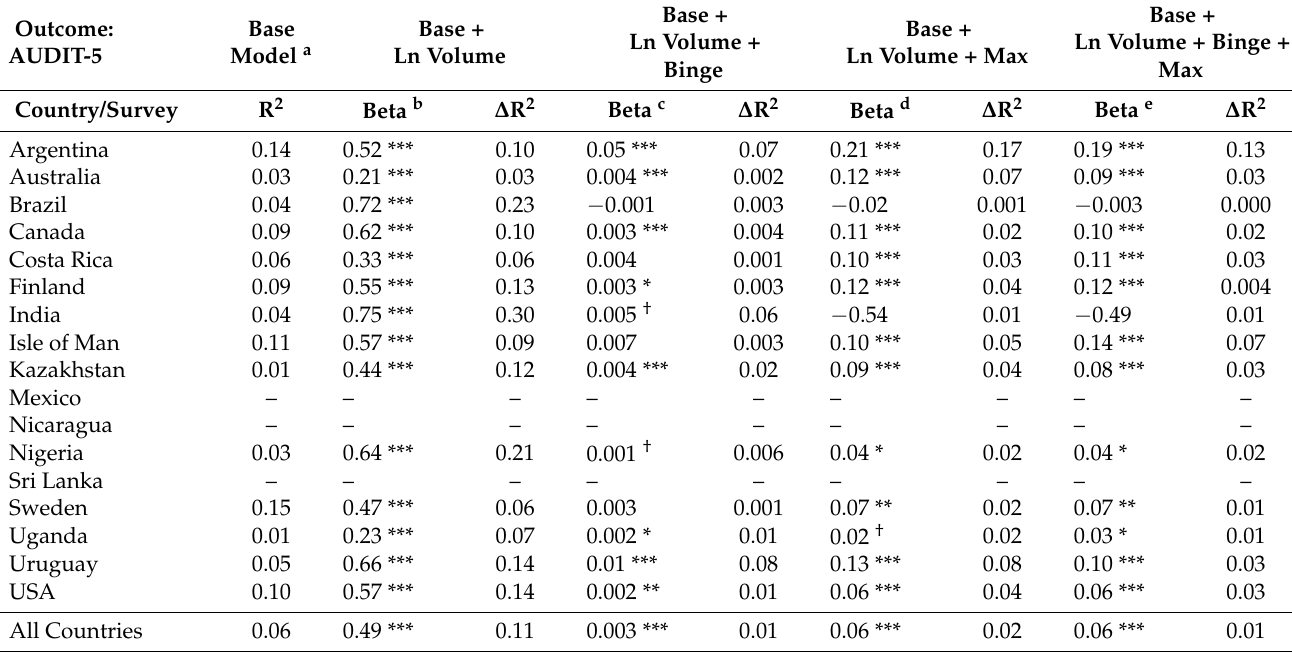
Table 6. Female Regressions Predicting